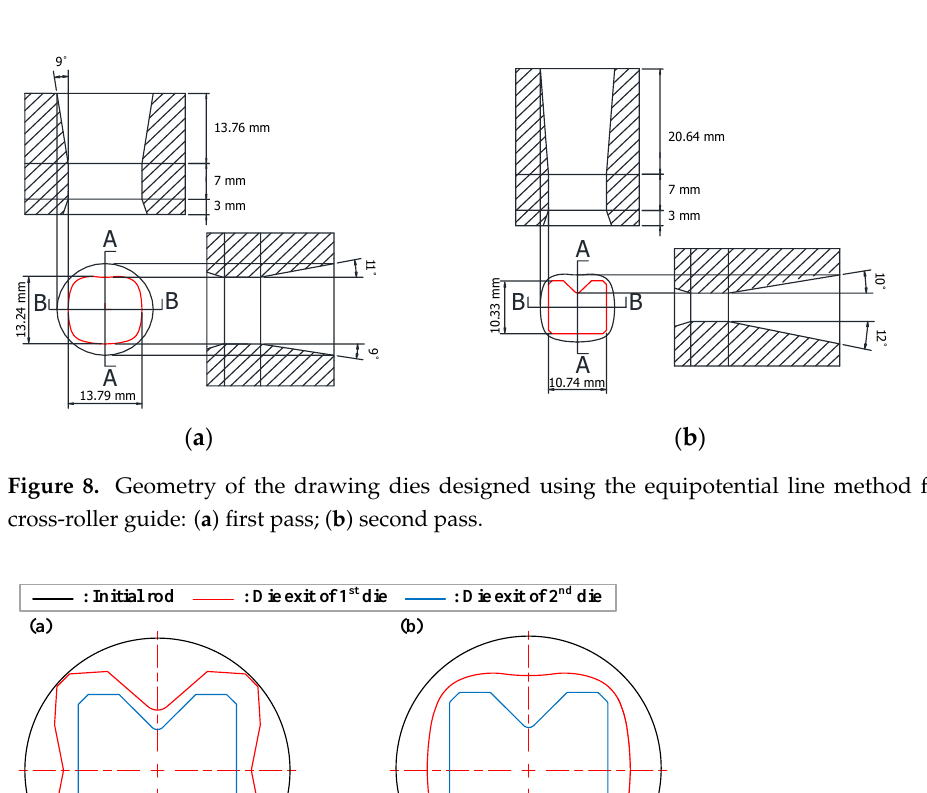
Figure 7. Geometry of the drawing dies designed using the ERV method for the cross-roller guide: ( a ) first pass; ( b ) second pass.